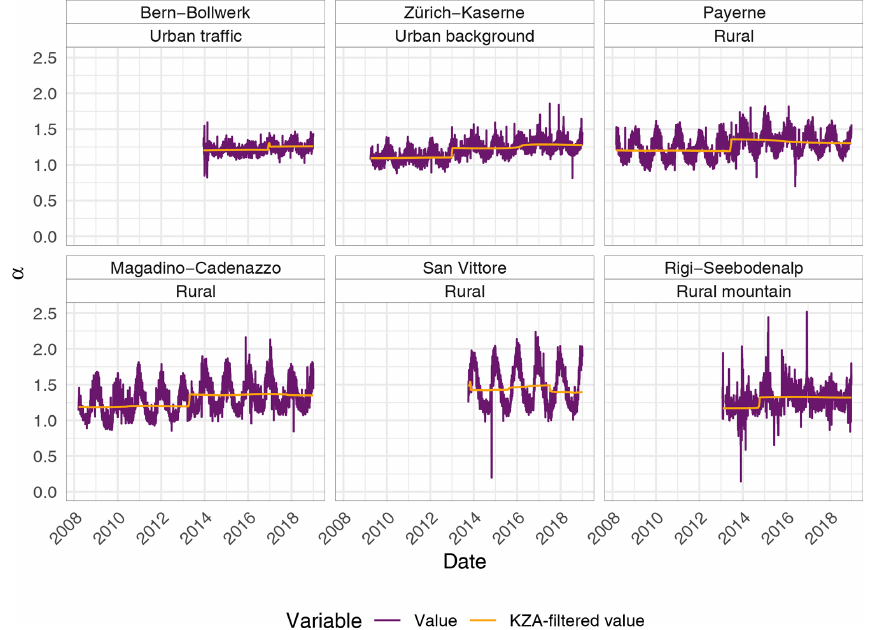
Figure A4. Time series of daily and adaptive Kolmogorov–Zurbenko-filtered (KZA) Ångström exponents ( α ) for six equivalent black carbon (EBC) monitoring sites’ absorption observations in Switzerland between 2008 and 2018. The α value has been calculated by wavelengths between 370 and